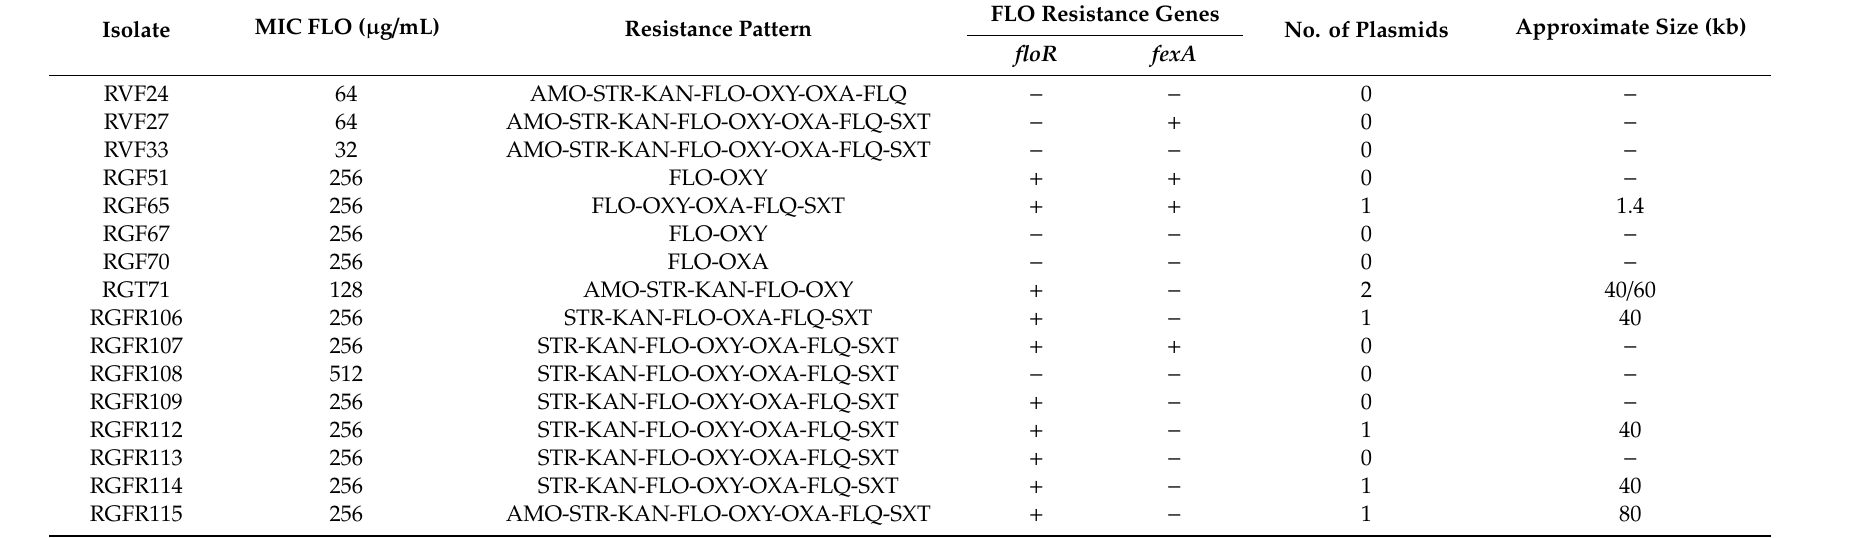
Table 4. Minimum inhibitory concentrations (MICs) of florfenicol (FLO), antimicrobial resistance patterns, florfenicol-resistance-encoding genes, and plasmid content of resistant isolates recovered from rotifer